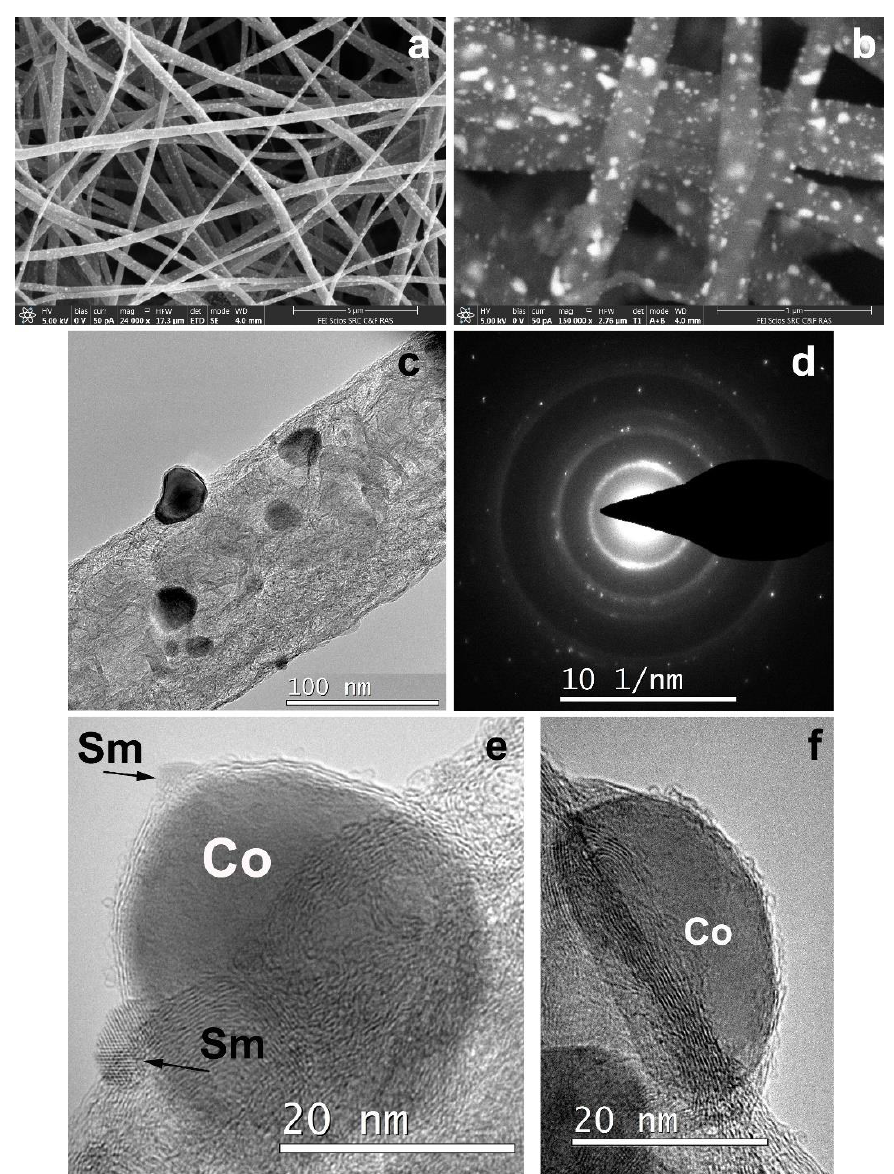
Figure 12. Structure of 3: ( a ) and ( b ) SEM images of CNF containing metal particles; ( c ) enlarged image of carbonized nanofiber; ( d ) Sm and Co reflexes in SAED pattern; ( e ) and ( f ) HRTEM images of Sm and Co particles grown on the surface of CNF.